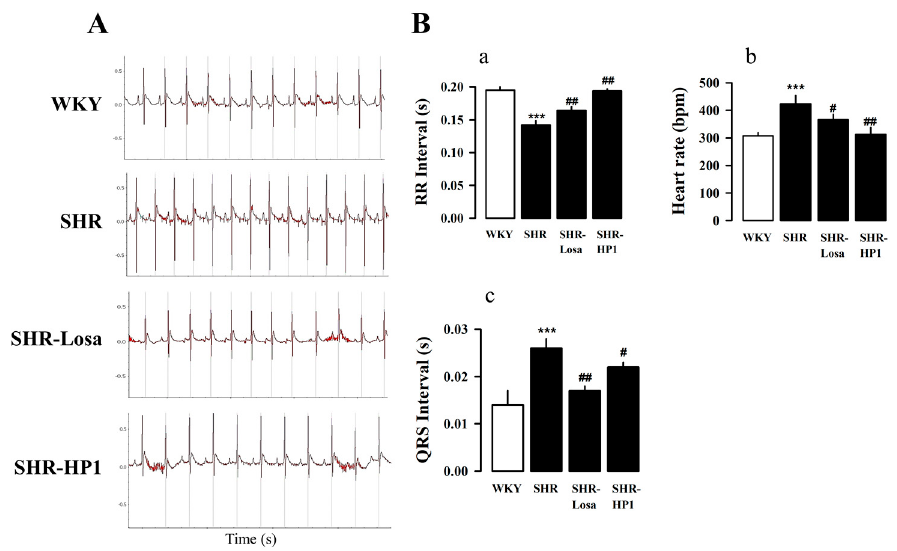
Figure 2. Effect of the electrocardiogram changes by HP1-treated in SHRs. Representative electrocardiogram (ECG) images of atrial and ventricular premature pulsation by HP1-treated in SHRs ( A ). The number of heart rate ( Ba ), RR interval ( Bb ), and QRS interval ( Bc ) for each rat was calculated from 5 min ECG recording. WKY, Wistar-Kyoto rat; SHR, spontaneously hypertensive rat; Losa, losartan; and HP1, Vitis labrusca leaves extract. Open bar, WKY; closed bar, SHRs. Data are shown as means ± standard error ( n = 10~12 for each group). *** p < 0.001, compared with the WKY group; # p < 0.05 and ## p < 0.01 compared with the SHR group.